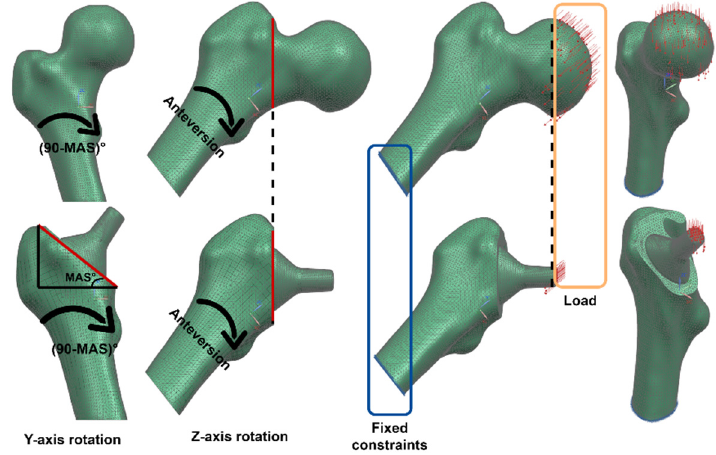
Figure 10. Boundary conditions for the intact and implanted femur.